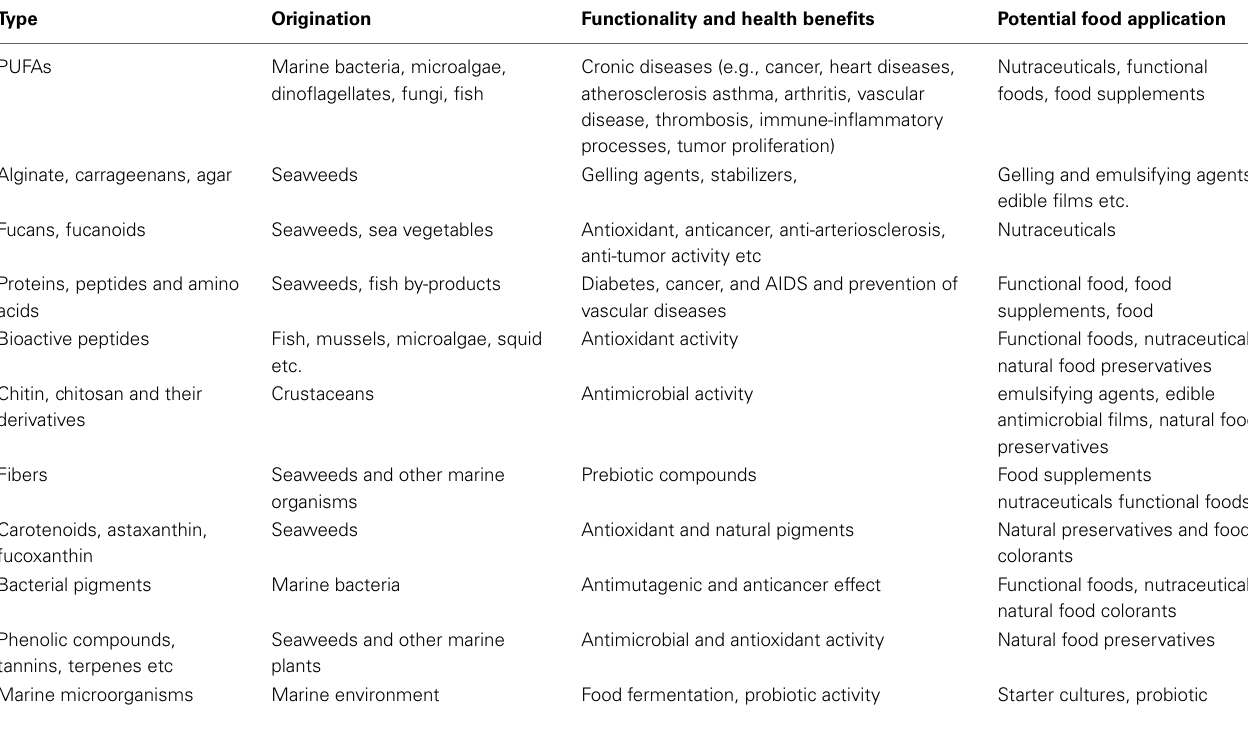
Table 1 | Examples of several compounds from marine organisms, their properties and their potential uses in the food